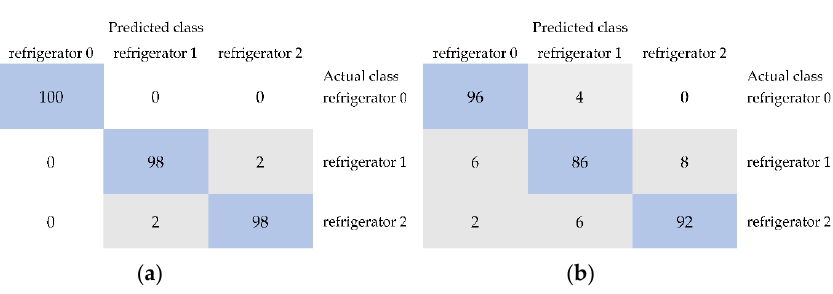
Figure 5. The confusion matrices of distinguishing unstored black currants (refrigerator 0) and samples stored in the refrigerator for 1 week (refrigerator 1) and 2 weeks (refrigerator 2) for models including selected image textures from color space Lab developed using the multilayer perceptron ( a ) and JRip ( b ).